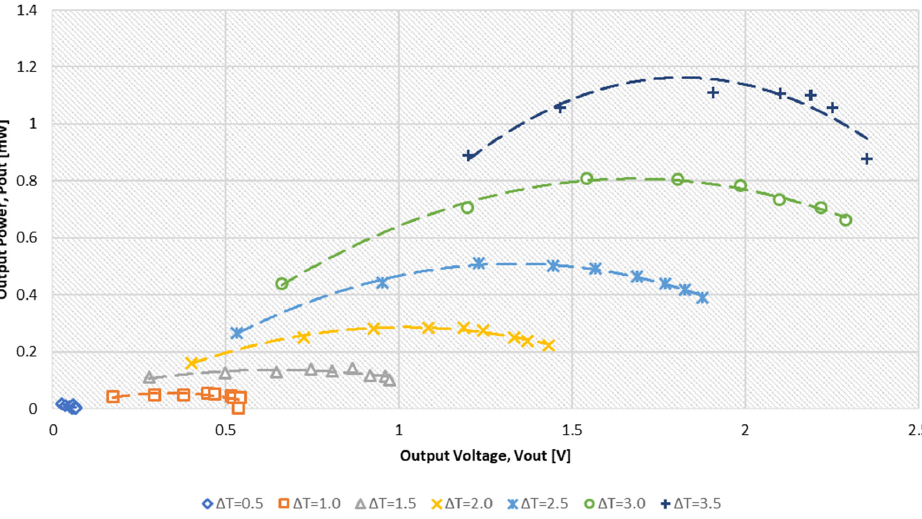
Figure 6. Thermal EHC Output Power–Output Current curve at 2.3 V.